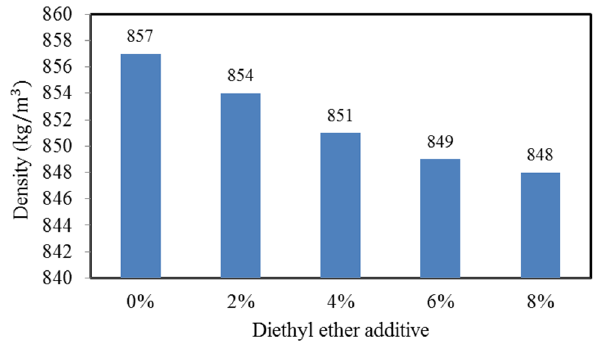
Figure 3. Effect of increasing diethyl ether percentage on blended B30 fuel density. Table 4. ANOVA for density.